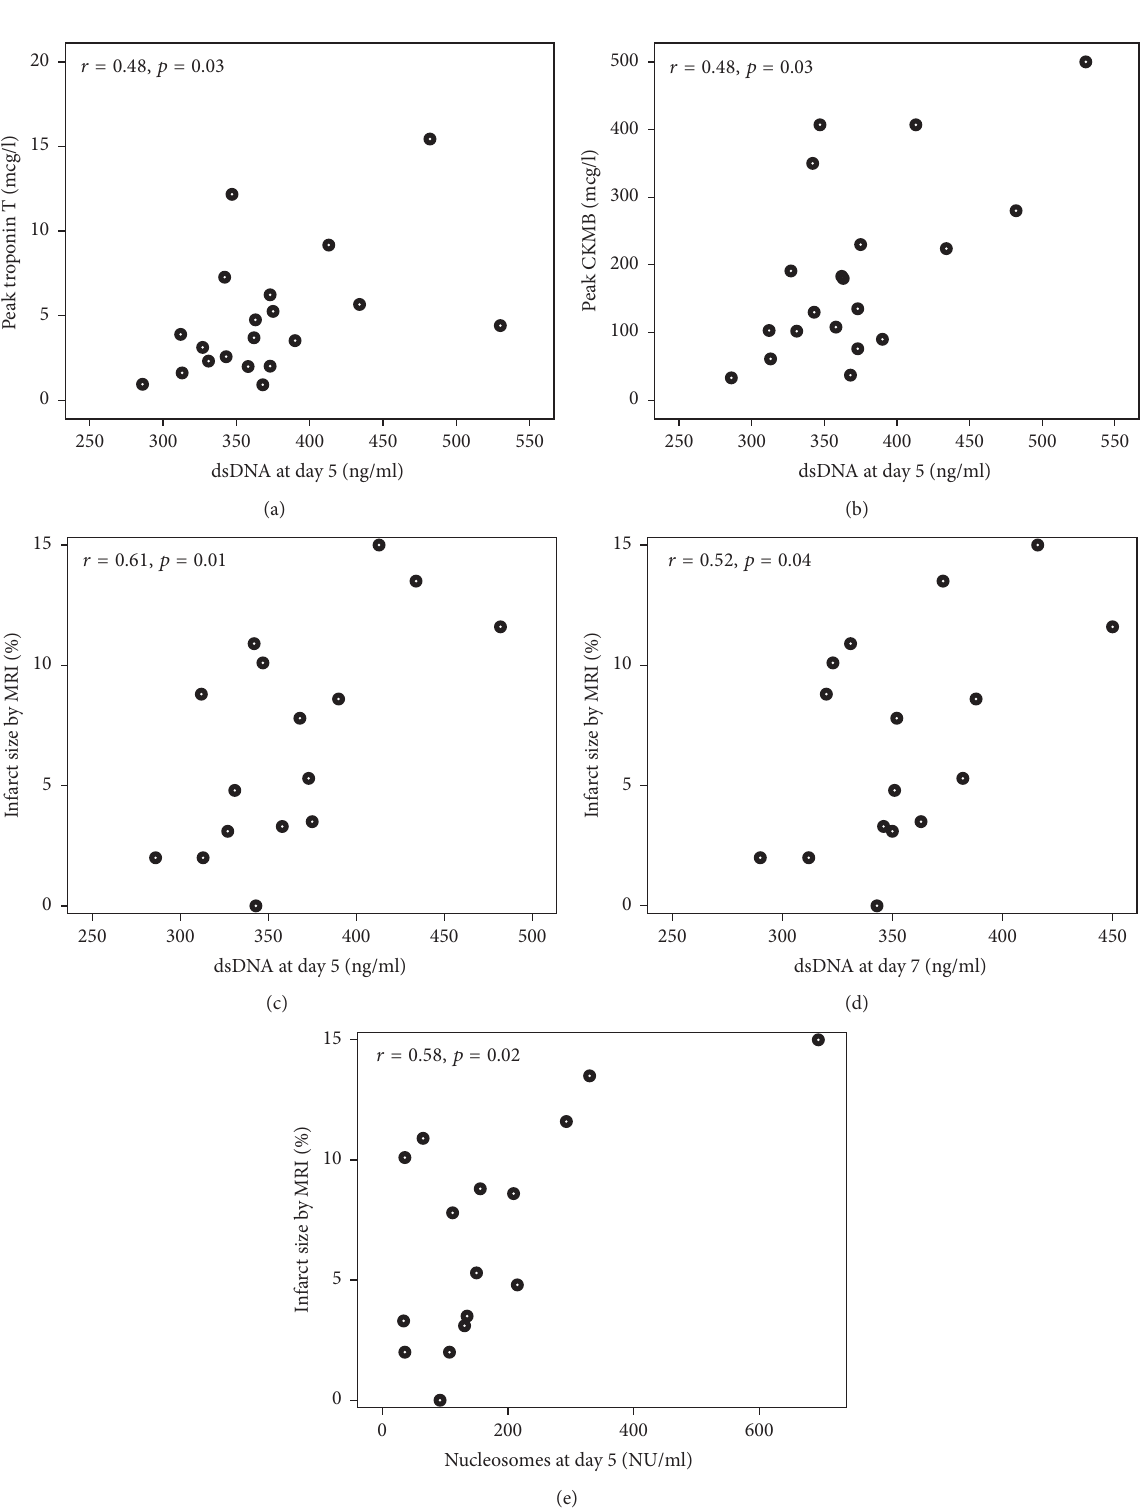
Figure 2: Correlations between NETs markers and indices of infarct size. dsDNA: double-stranded deoxyribonucleic acid. CKMB: creatine kinase MB. MRI: magnetic resonance